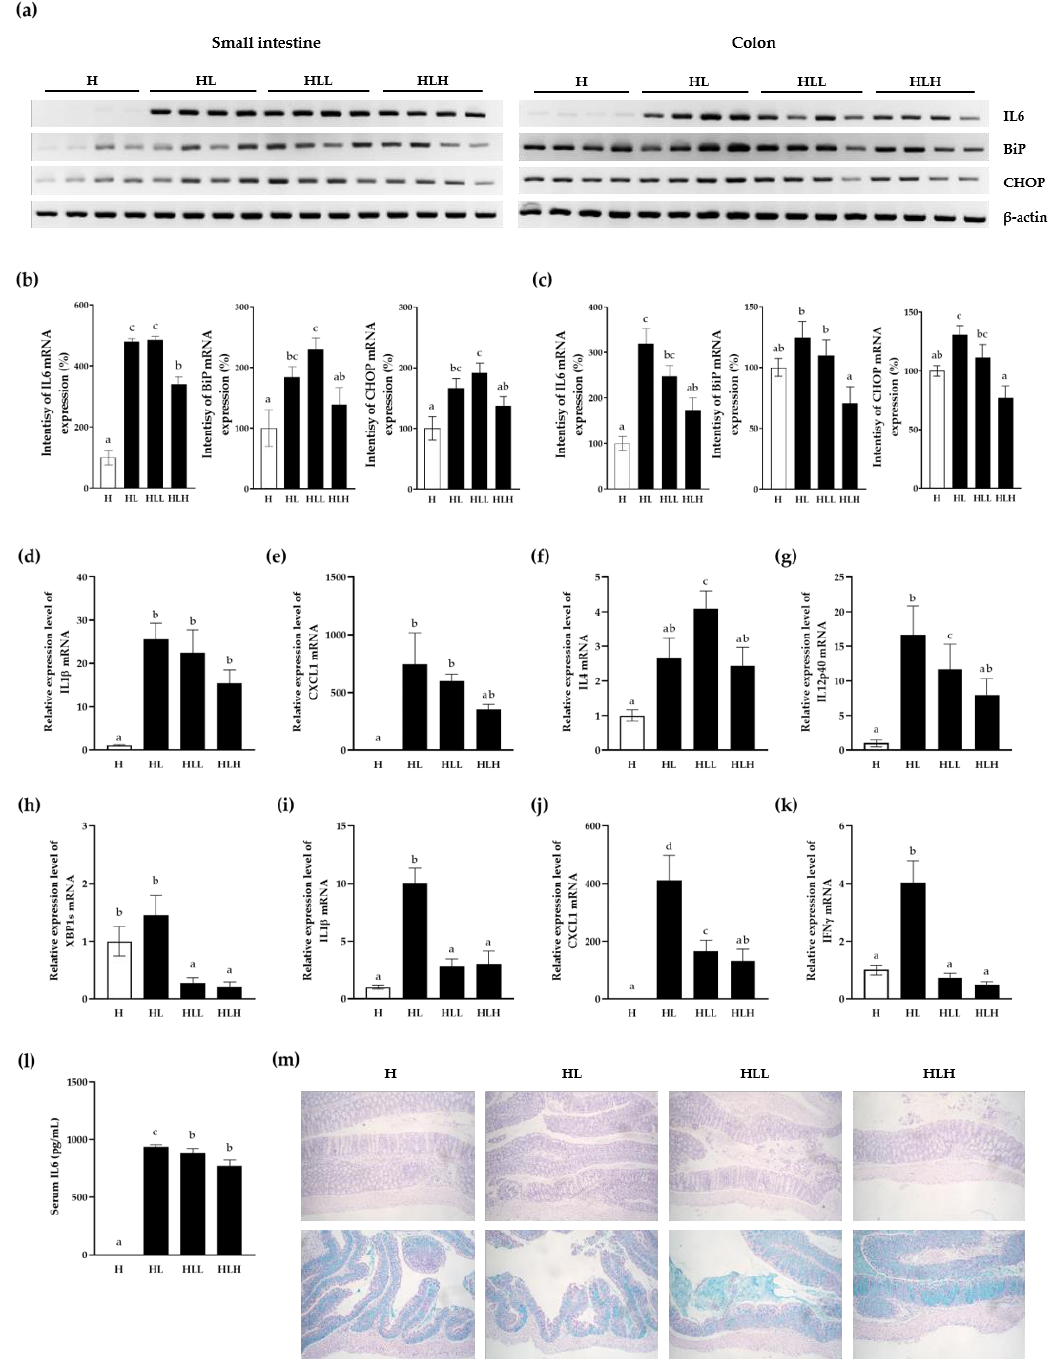
Figure 5. Anti-inflammatory effect of LL in the small intestine of the mice. The mice were fed with HFD alone for 23 days. Subsequently, 150 mg/kg and 300 mg/kg LL were administered daily for the next 20 days, along with HFD. Mice were i.p. with a 5 mg/kg of LPS followed by sacrifice after 1 h. The small intestine ( a , b , d – g ), the colon ( a , c , h – k ) and serum ( l ) were harvested for RT-PCR ( a – c ), real-time qPCR ( d – k ) and ELISA ( l ). β-actin was used as the loading control. The data are shown as the means ± SD of three independent experiments. The colons were harvested and stained with H&E and PAS ( m ). The white bar represents negative control. Data are shown as the means ± SD of at least three independent experiments. Significant differences between different groups were analyzed using Duncan’s multiple range test with one-way ANOVA and values labeled with different letters are significantly different ( p < 0.05). HFD diet; H, HFD diet + LPS; HL, HFD + LPS + 150 mg/kg LL; HLL, HFD + LPS + 300 mg/kg;